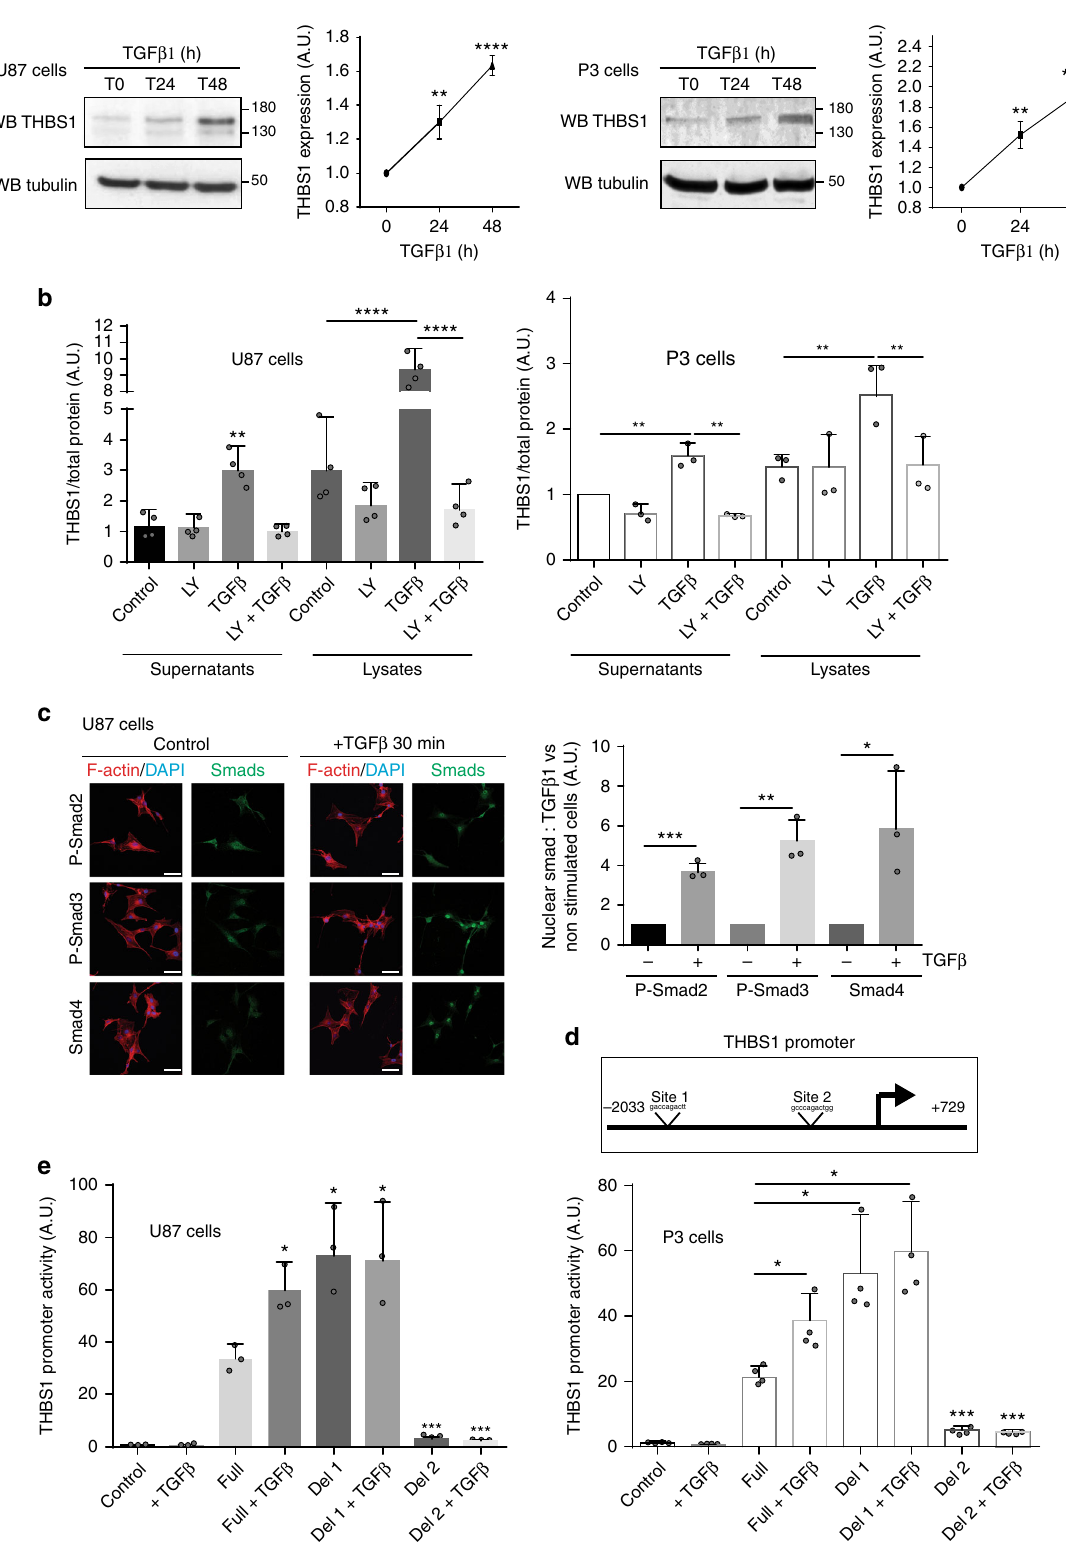
completely blocked by the speci fi c TGF β receptor inhibitor, LY2157299, in cell lysates, but also in supernatants (Fig. 2b). To analyse canonical downstream signalling of TGF β 1, immunos- tainings for P-SMAD2, P-SMAD3 and SMAD4 were performed. All SMAD proteins were found to be located in the nuclei of U87